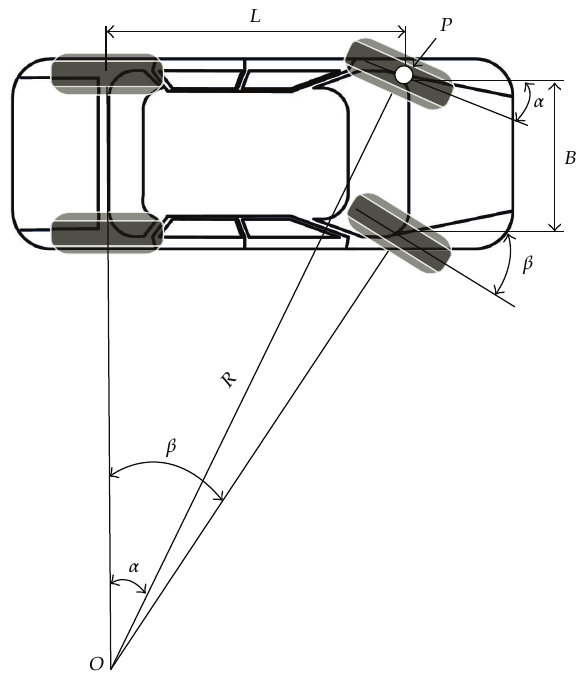
Figure 5: Optimal relationship of steering